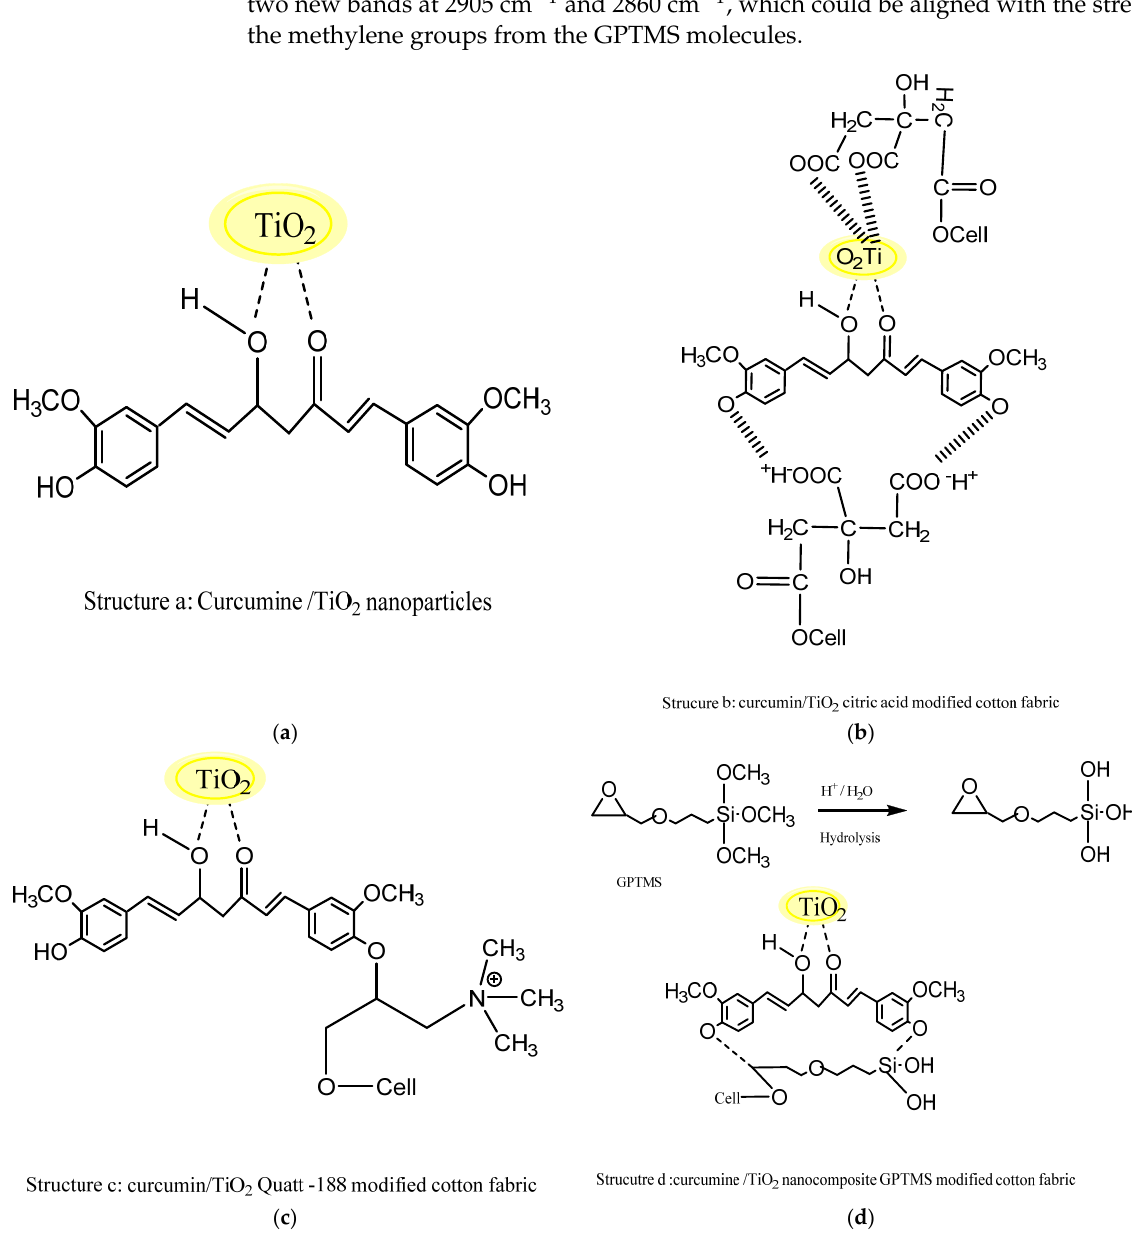
Figure 1. Schematic of the mechanism for the deposition of the curcumin/TiO 2 nanocomposite on cotton fabrics. ( a ) Struc- ture a: curcumine/TiO 2 nanoparticles; ( b ) Structure b: curcumin TiO 2 : citric acid modified cotton fabric; ( c ) Structure c: curcumin/TiO 2 , Quatt-188 modified cotton fabric; ( d ) Structure d: curcumine/TiO 2 , nanocomposite GPTMS modified cot- ton fabric.